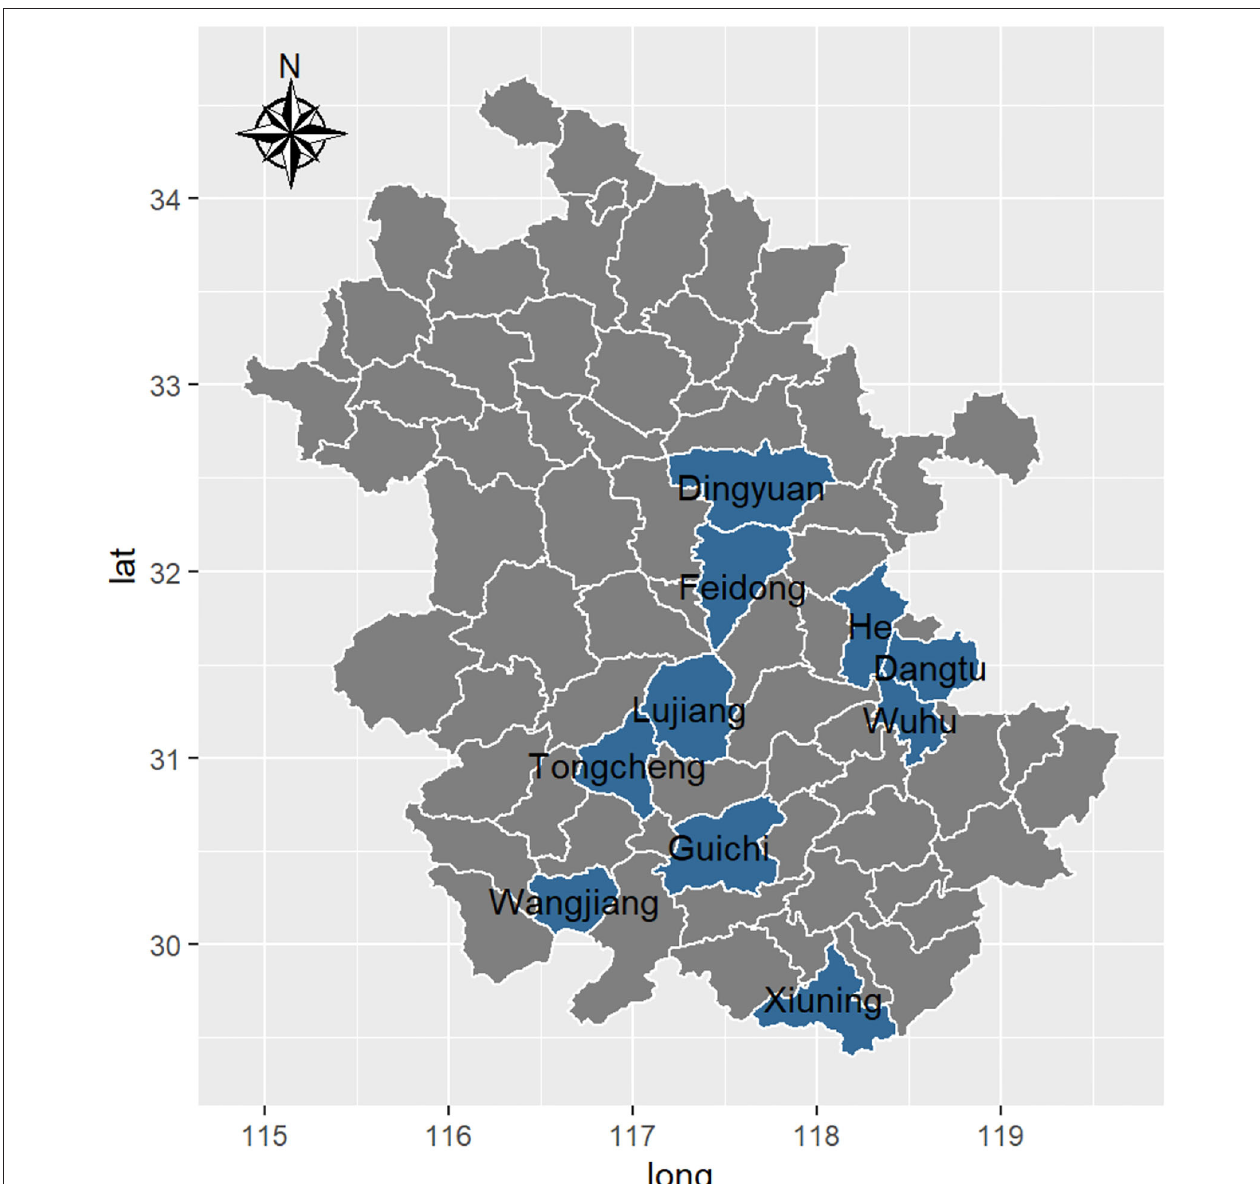
FIGURE 1 | County boundaries in Anhui